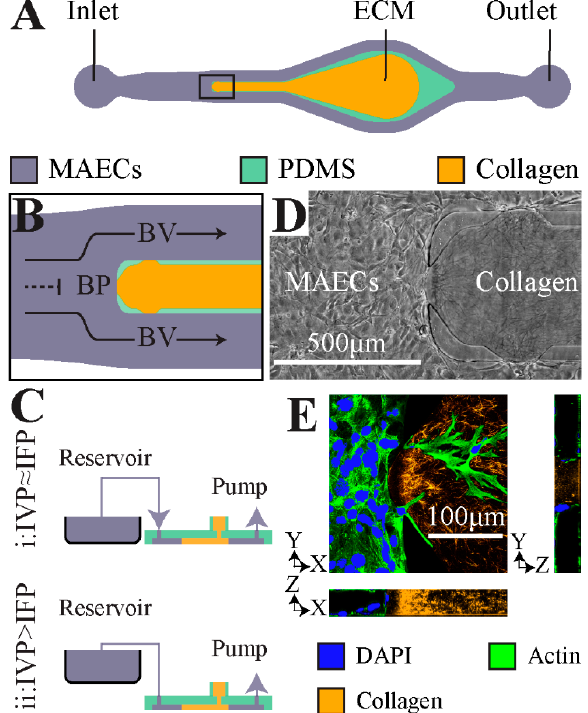
Figure 1. Schematic and characterization of the in vitro microfluidic device reported previously [14] used here for examination of sprouting angiogenesis. ( A ) Top-view for the microfluidic device. ( B ) Schematic showing a close-up for the local fluid flow at the bifurcation point (BP) aperture and the flow along apertures in the branched vessel (BV). ( C ) The schematic of the approach implemented to control the difference between intravascular pressure ( IVP) and the interstitial fluid pressure (IFP) through controlled elevation of the reservoir. ( D ) A representative phase-contrast image of the BP fully lined with mouse aortic endothelial cells (MAECs) adjacent to the polymerized extracellular matrix (ECM) hydrogel. ( E ) A representative confocal image of the microfluidic device fully seeded with MAECs. Furthermore, the 3-D structure of the polymerized collagen matrix (orange) was resolved using total reflectance confocal imaging.